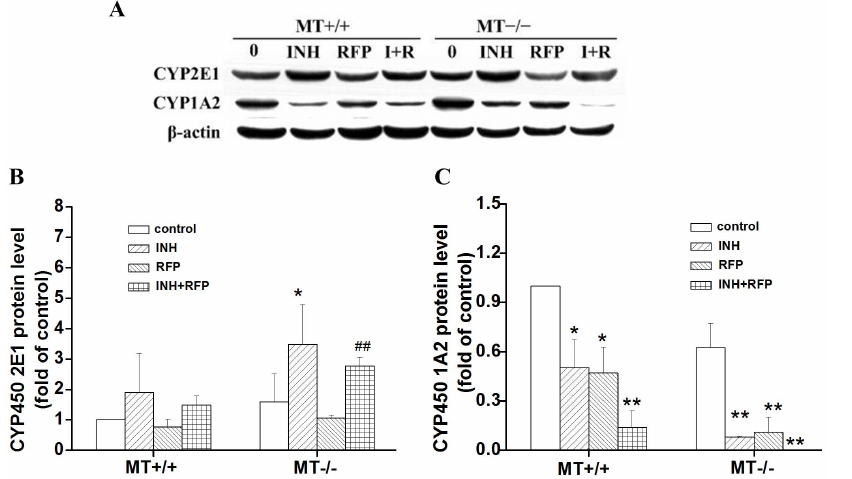
Figure 4. Effect of INH and RFP treatment on the expressions of CYP2E1 and CYP1A2 in wild-type (MT + / + ) and MT 2 / 2 mice. The expression of CYP2E1 and CYP1A2 was analyzed by Western blotting. **p , 0.01, compared with respective control; *p , 0.05, compared with respective control; ## p , 0.01, compared with MT + / + mice for the same treatment. doi:10.1371/journal.pone.0072058.g004 PLOS ONE |